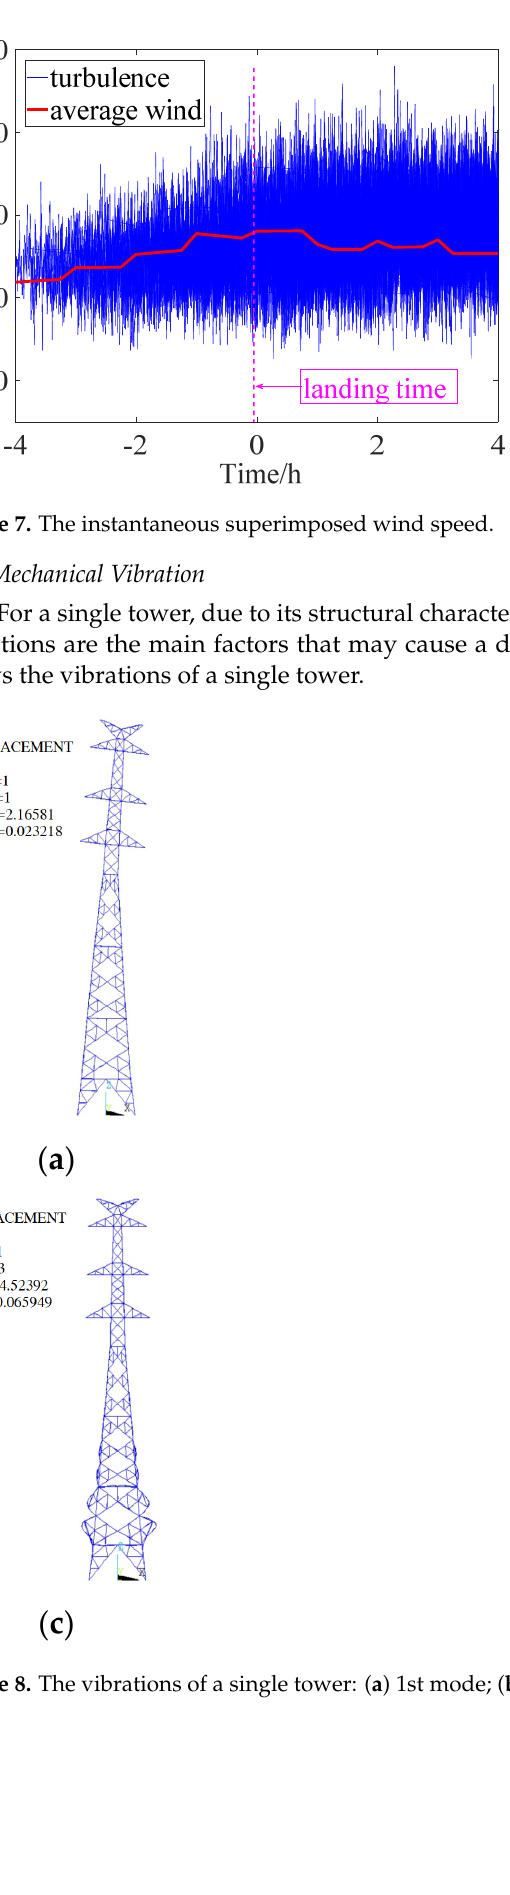
Figure 6. The real-time average wind speed.